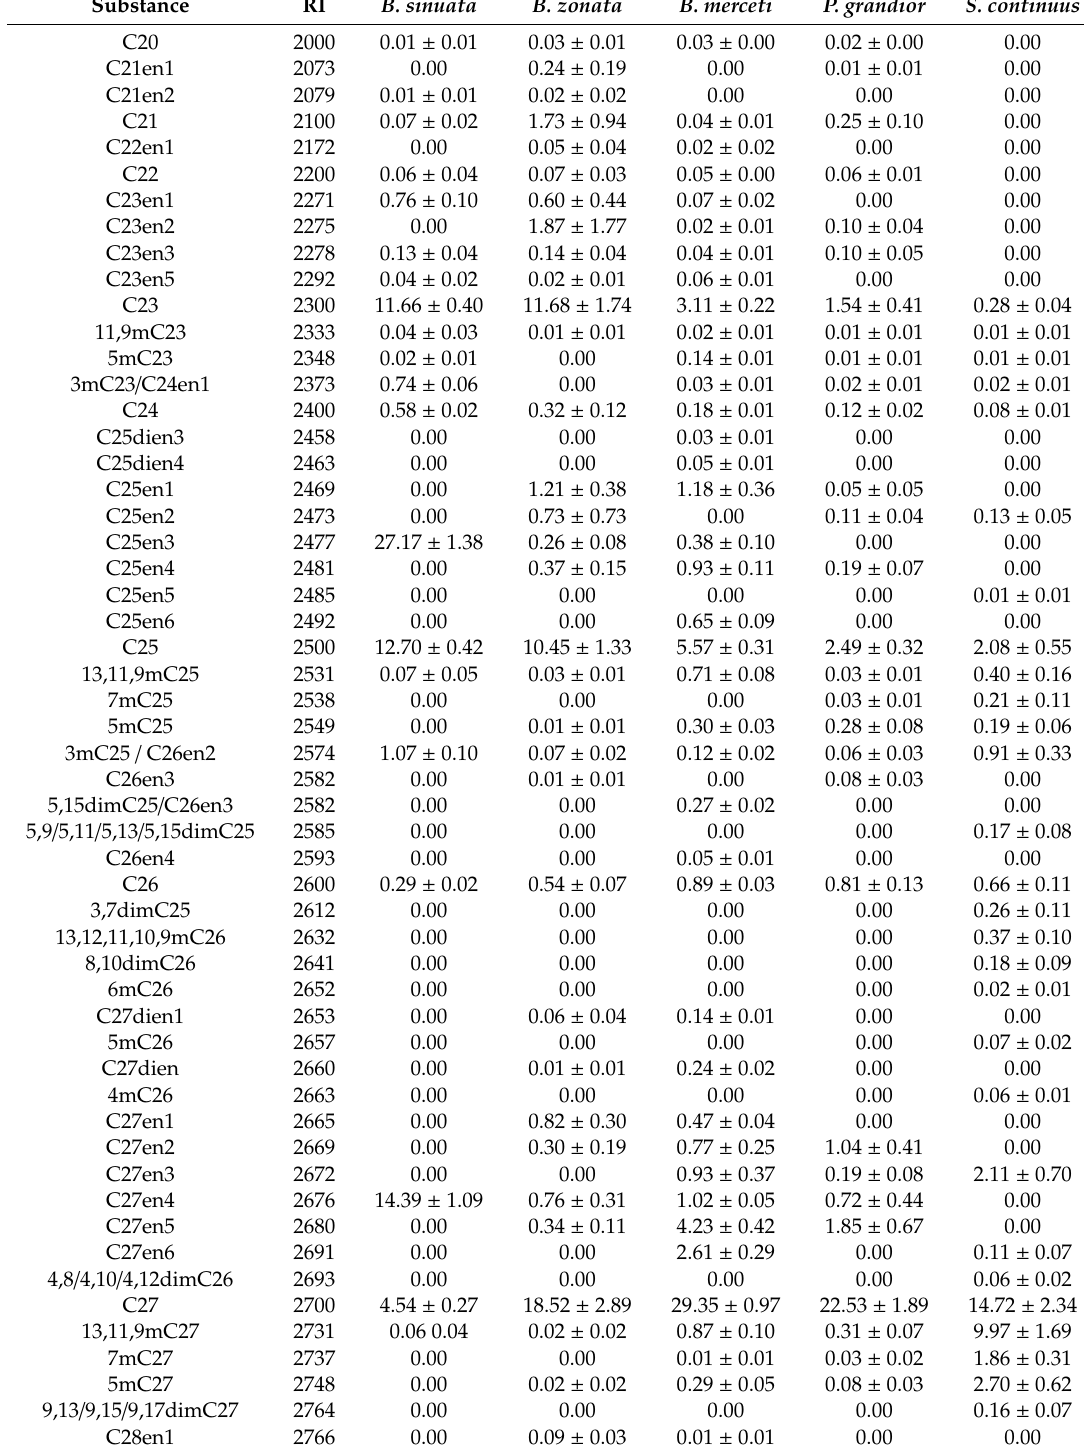
Table A1. Mean value ± standard error of the relative peak area (%) of substances (only those that make up > 0.01% per individual and are present in at least half of the group, see Methods) in the cuticular hydrocarbon profiles of the five studied species. The retention index (RI) for each peak is